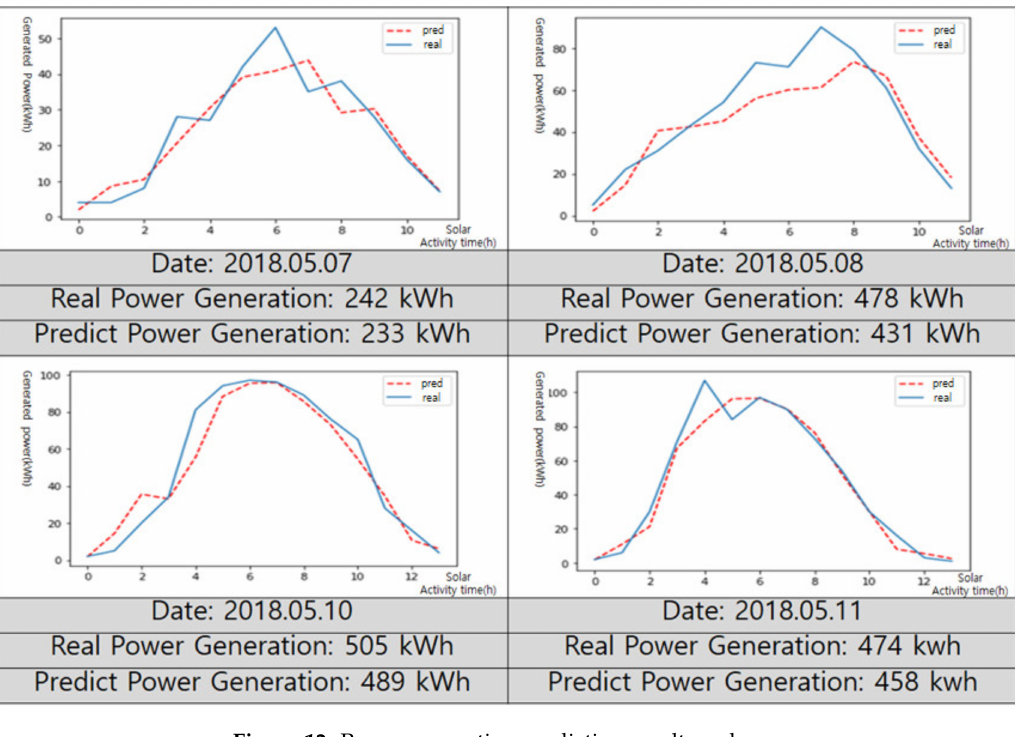
Figure 12. Power generation prediction result per hour.